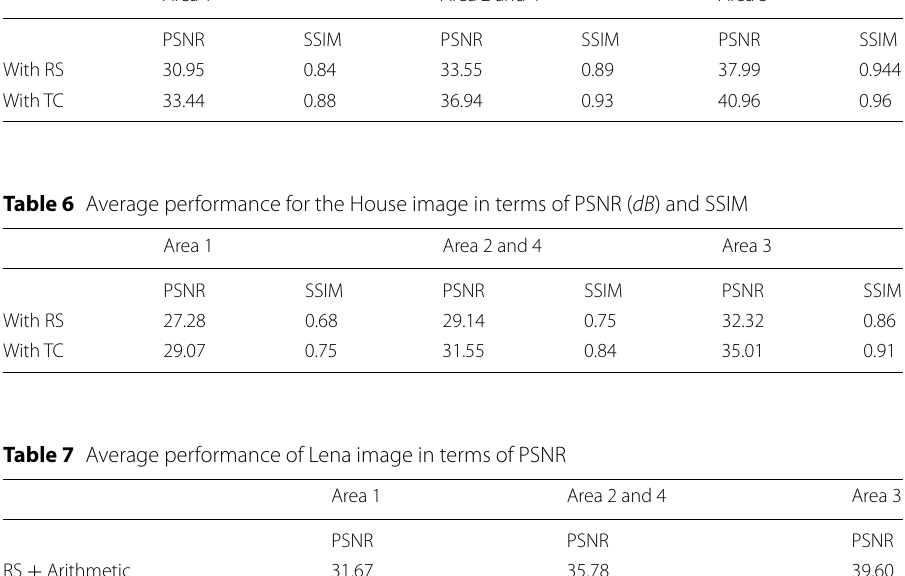
Table 5 Average performance for the Caps image in terms of PSNR ( dB ) and SSIM Area 1 Area 2 and 4 With RS